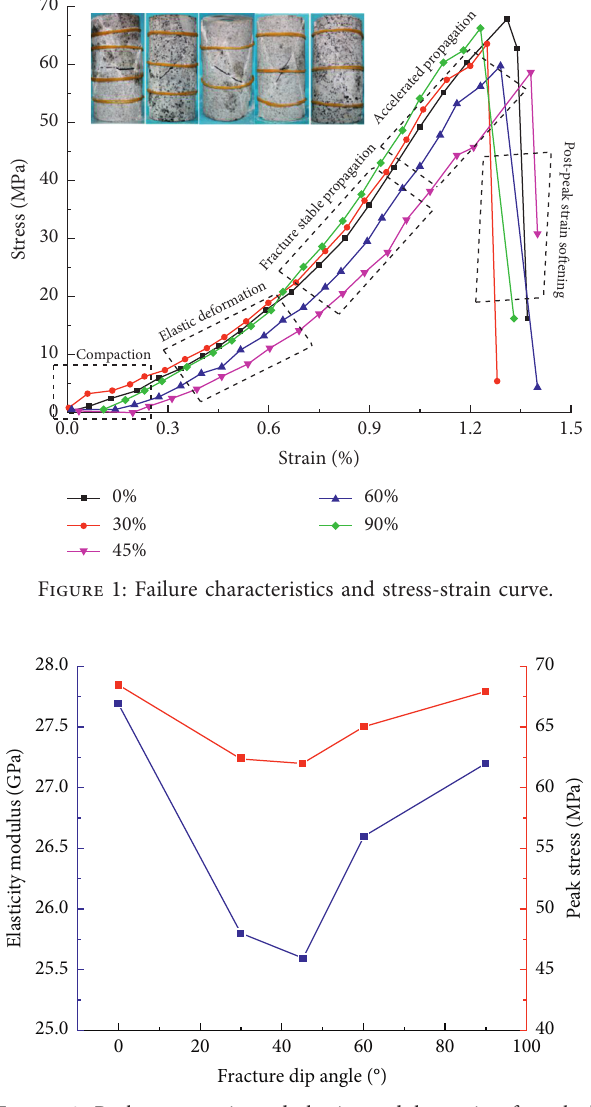
Figure 2: Peak stress ratio and elastic modulus ratio of cracked